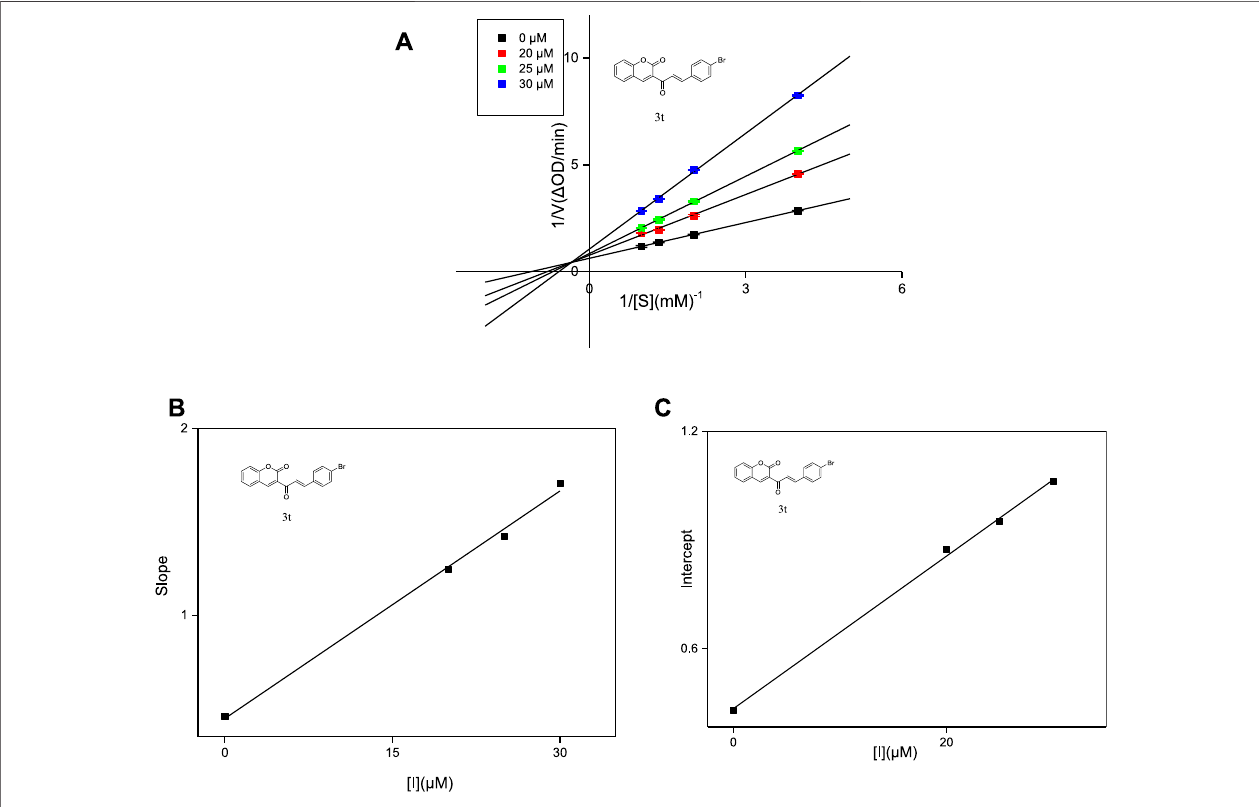
FIGURE 3 | Lineweaver-Burk plots of compounds 3t on α -glucosidase (A) . Plot of slope vs. the concentration of compounds for the calculation of the inhibition constant K I (B) . Plot of intercept vs. the concentration of compounds for the determination of the inhibition constant K IS (C) .